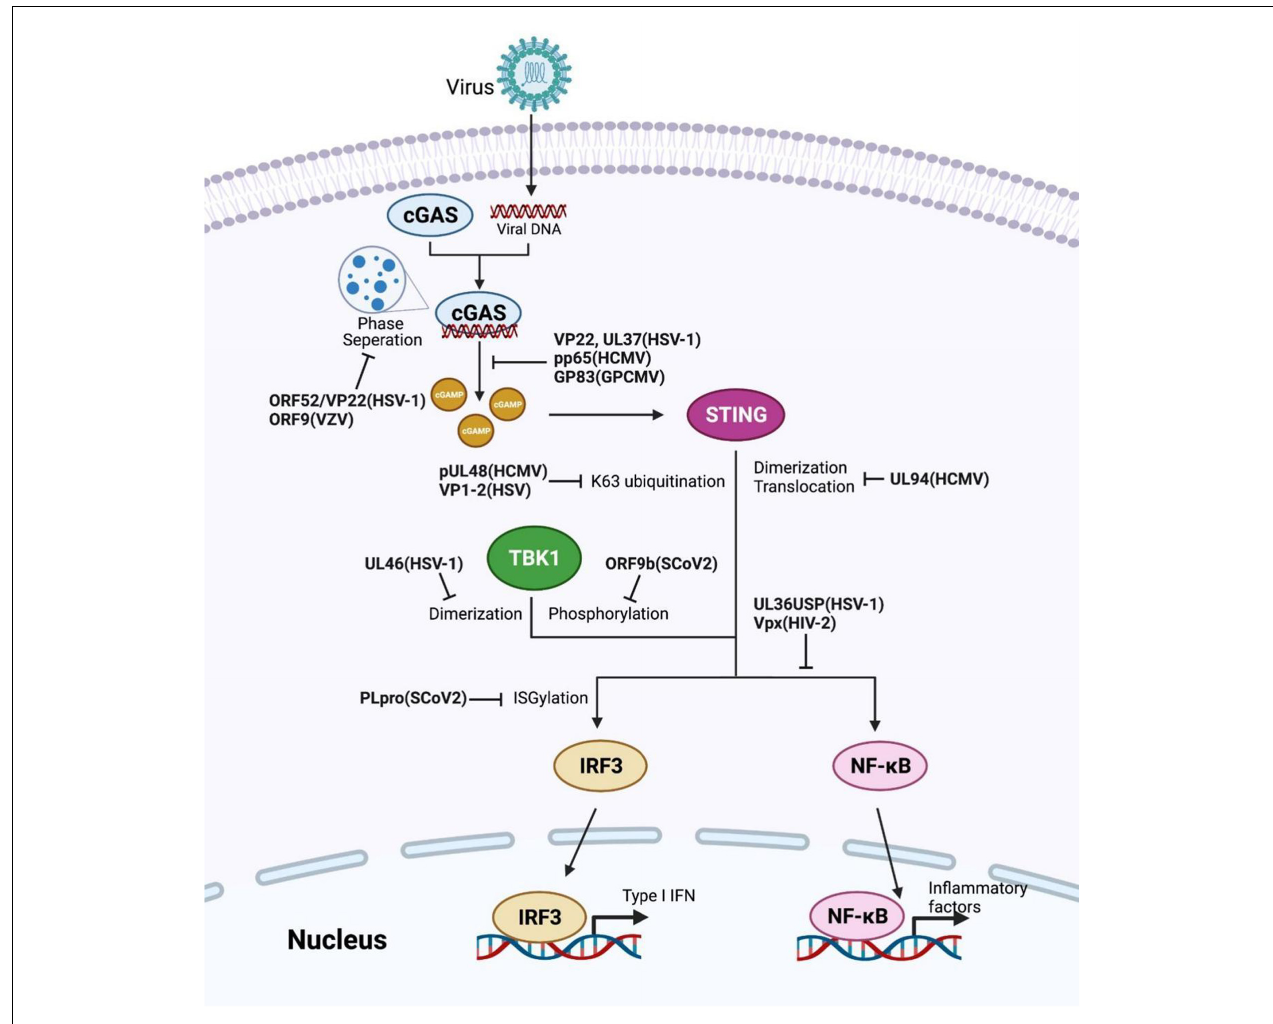
FIGURE 2 | Viral proteins induced evasion strategies by restricting the cGAS-STING axis. Several reported viral proteins dysregulate different checkpoints in the cGAS-STING pathway, such as invalidating the enzyme activity of cGAS or TBK1, obstructing STING activation, altering the modifications of key components. The corresponding viral proteins and their species are labeled in